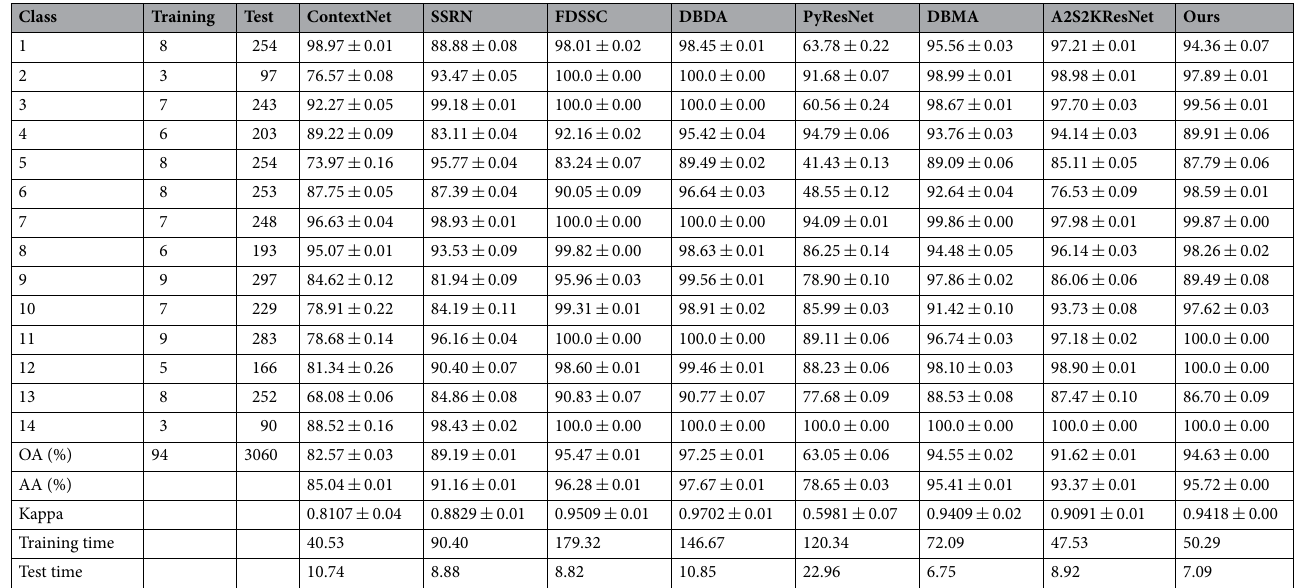
Table 4. The objective indicators on Botswana (using 3% training, 3% verification, 94% testing).